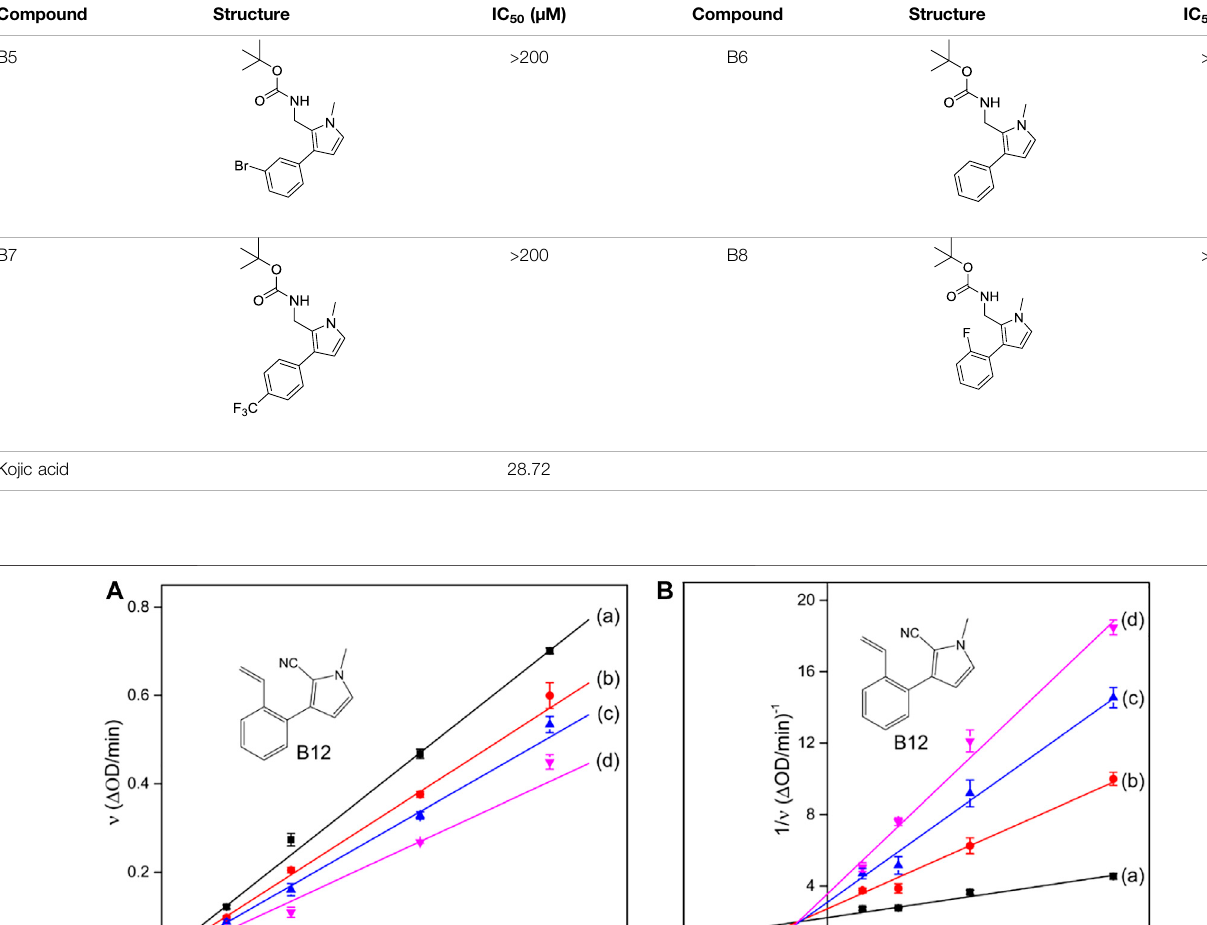
TABLE 1 | ( Continued ) Inhibitory activity of N-heterocycle derivatives on